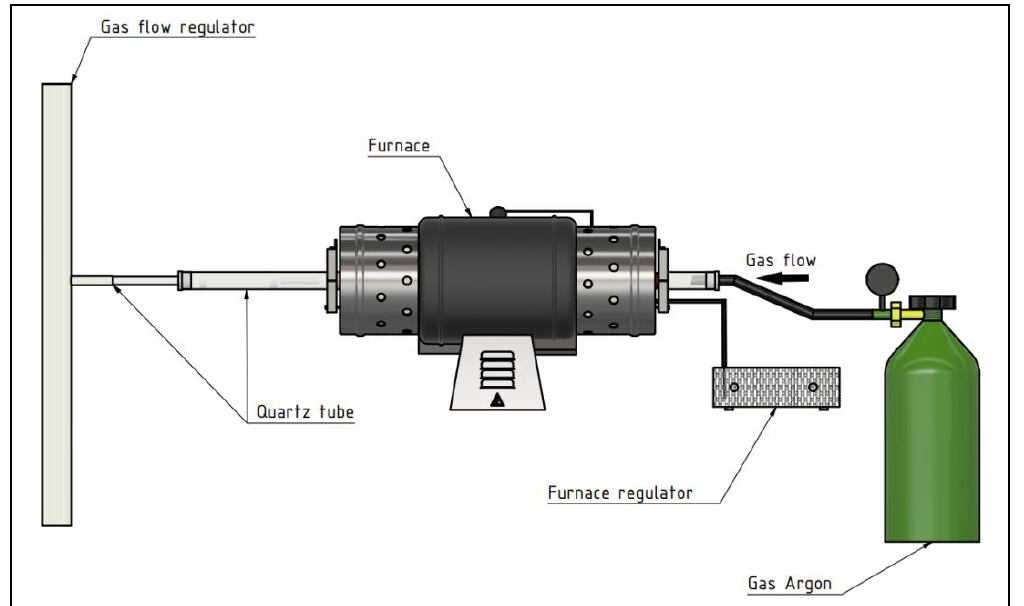
Figure 5. The scheme of apparatus built for experiments: (from left to right) gas flow regulator, quartz tube of diameter 20 mm, quartz tube of diameter 12 mm (inserted in the 20 mm quartz tube), the pipe resistance furnace, furnace regulator, and gas bomb.